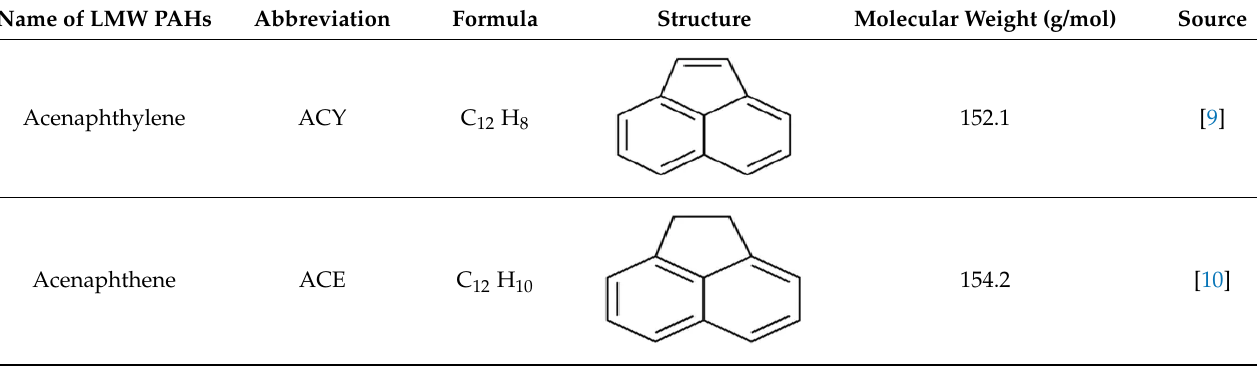
Table 1. Types of LMW polycyclic aromatics hydrocarbons and their molecular structure.